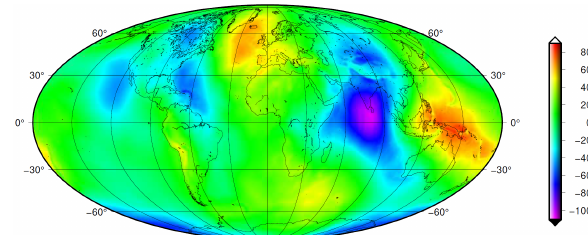
Fig. 1. Geoidal heights (in meters) of model GOCO06s with respect to the oblate spheroid WGS 84 in Mollweide projection. mean = −0.05 m, min = −106.33 m, max = 85.31 m, rms = 30.59